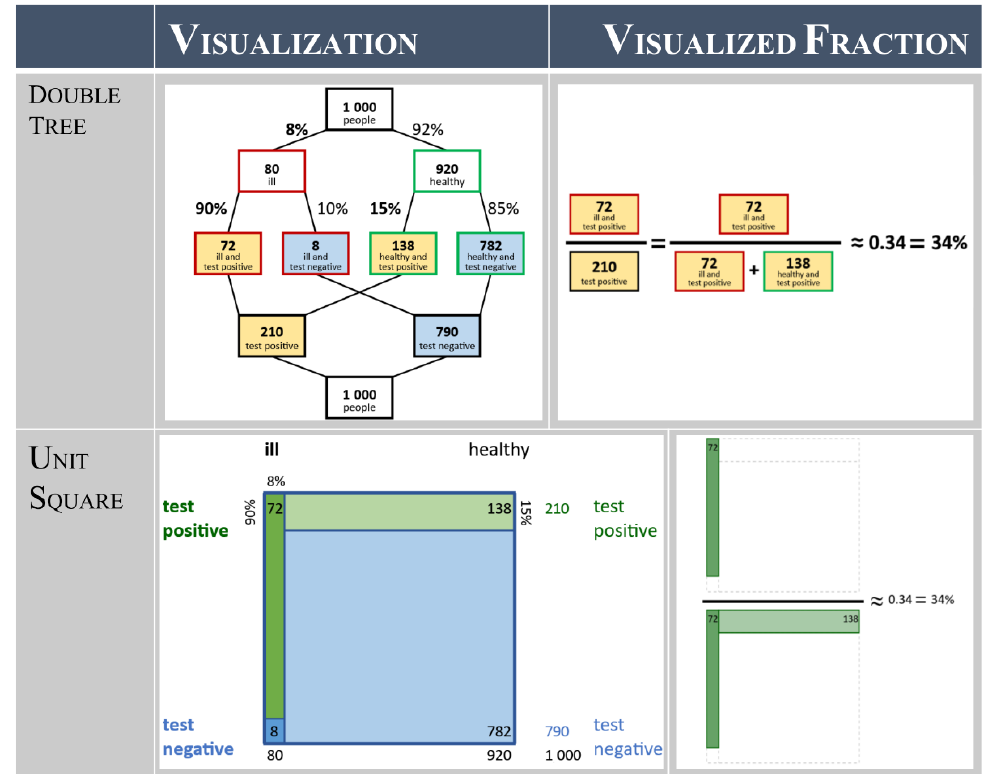
Figure 3. Representations of a Bayesian situation, which serve as mental models for performance.